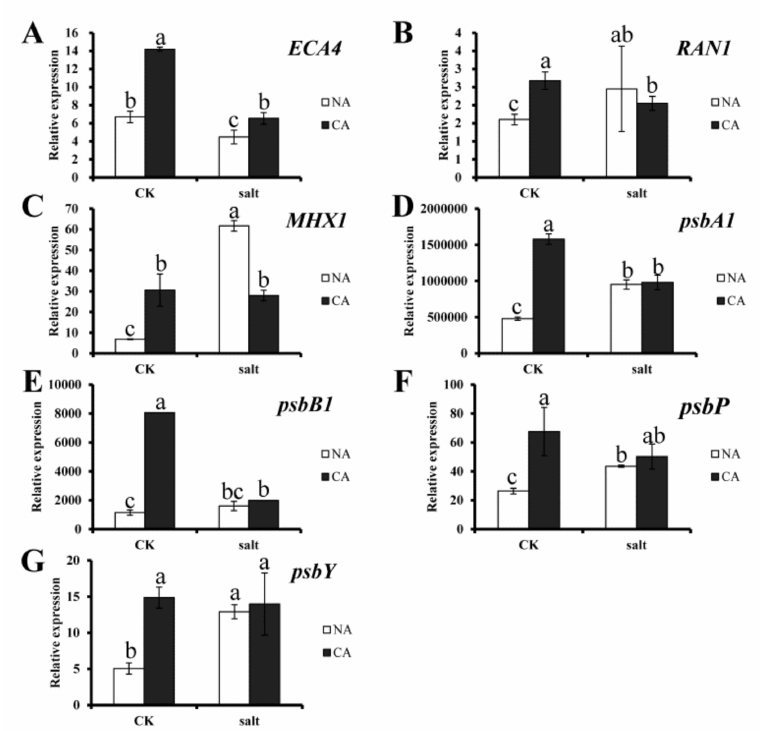
Figure 6. Expression of candidate genes in bermudagrass under di ff erent treatments. ( A ) ECA4 gene expression; ( B ) RAN1 gene expression; ( C ) MHX1 gene expression; ( D ) psbA1 gene expression; ( E ) psbB1 gene expression; ( F ) psbP gene expression; ( G ) psbY gene expression. Quantitative real-time PCR was repeated three times. One-way analysis of variance (ANOVA), Duncan’s multiple range test was used to determine statistical di ff erences. Bars show